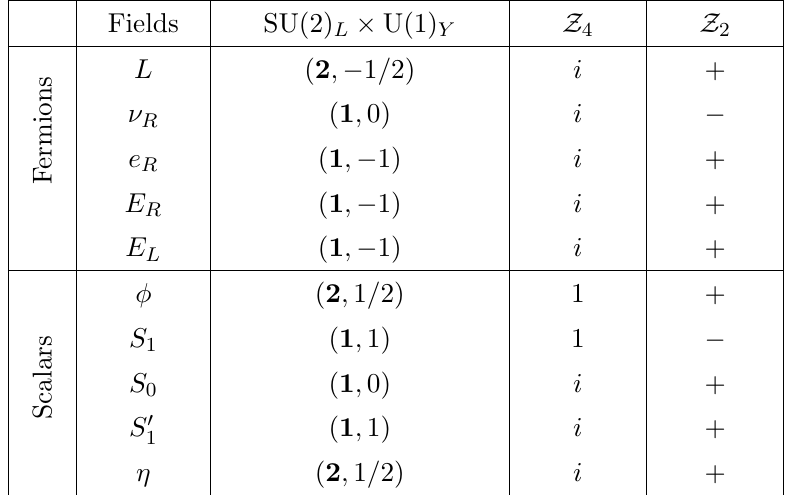
Table 3 . Particle content of the example (cid:30)(cid:30)S model. The gauge charges along with the charges are also shown. All the (cid:12)elds listed in the table are SU(3) C singlets. Again, the role of is to protect Diracness and to stabilize the dark matter candidate: the lightest out of S 0 and the neutral component of (cid:17) . The symmetry forbids the neutrino tree-level mass L(cid:30) c (cid:23) R and it is Z 2 softly broken to allow the two-loop realization of such operator.